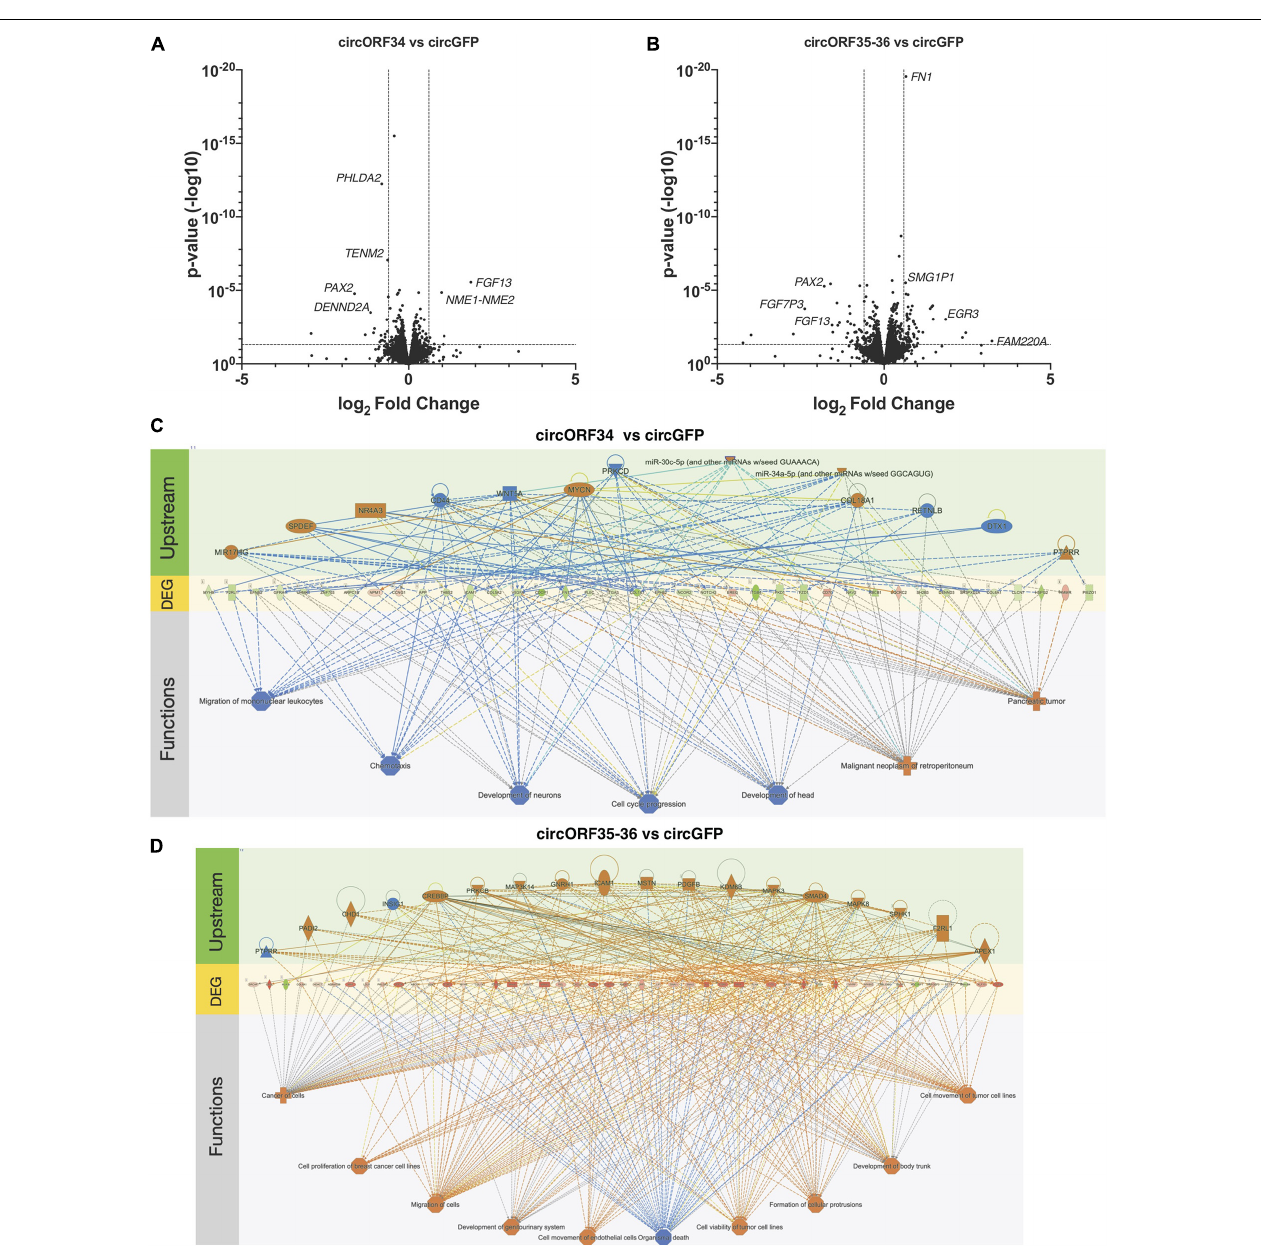
FIGURE 6 | Transcriptomes change by specific viral circRNAs. KSHV-negative SLK cell lines that constitutively express select KSHV circRNAs were subjected to total RNA-Seq analysis. (A,B) Volcano plots showing differential gene expressions in circORF34- (A) or circORF35-36- (B) expressing cell lines compared to circGFP (negative control). Adjusted p -value of 0.05 and fold-change of | 1.5| are marked. (C,D) Regulator effects analysis in Ingenuity Pathway Analysis package are shown. Upstream regulators and downstream functions are predicted based on the genes differentially expressed by circORF34 (C) or circORF35-36 (D) ( n = 3). Blue colors denote repression and orange colors denote stimulation. Green and red shades denote the level of increased or decreased expression induced by the circORF34 or circORF35-36. Dotted lines denote indirect regulations and solid lines show known direct